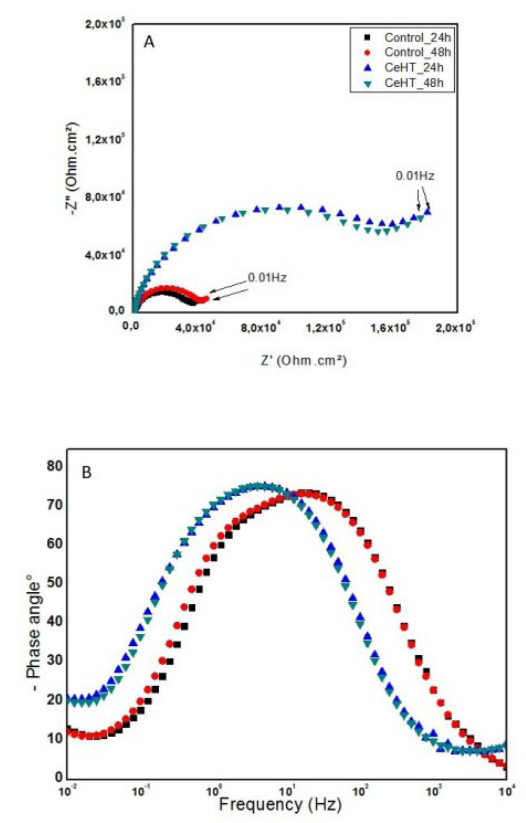
Figure 1. EIS results for AA1230 clad on AA2024 alloy with various pre-treatments after 24 h and 48 h in 0.1 mol L -1 NaCl solution.